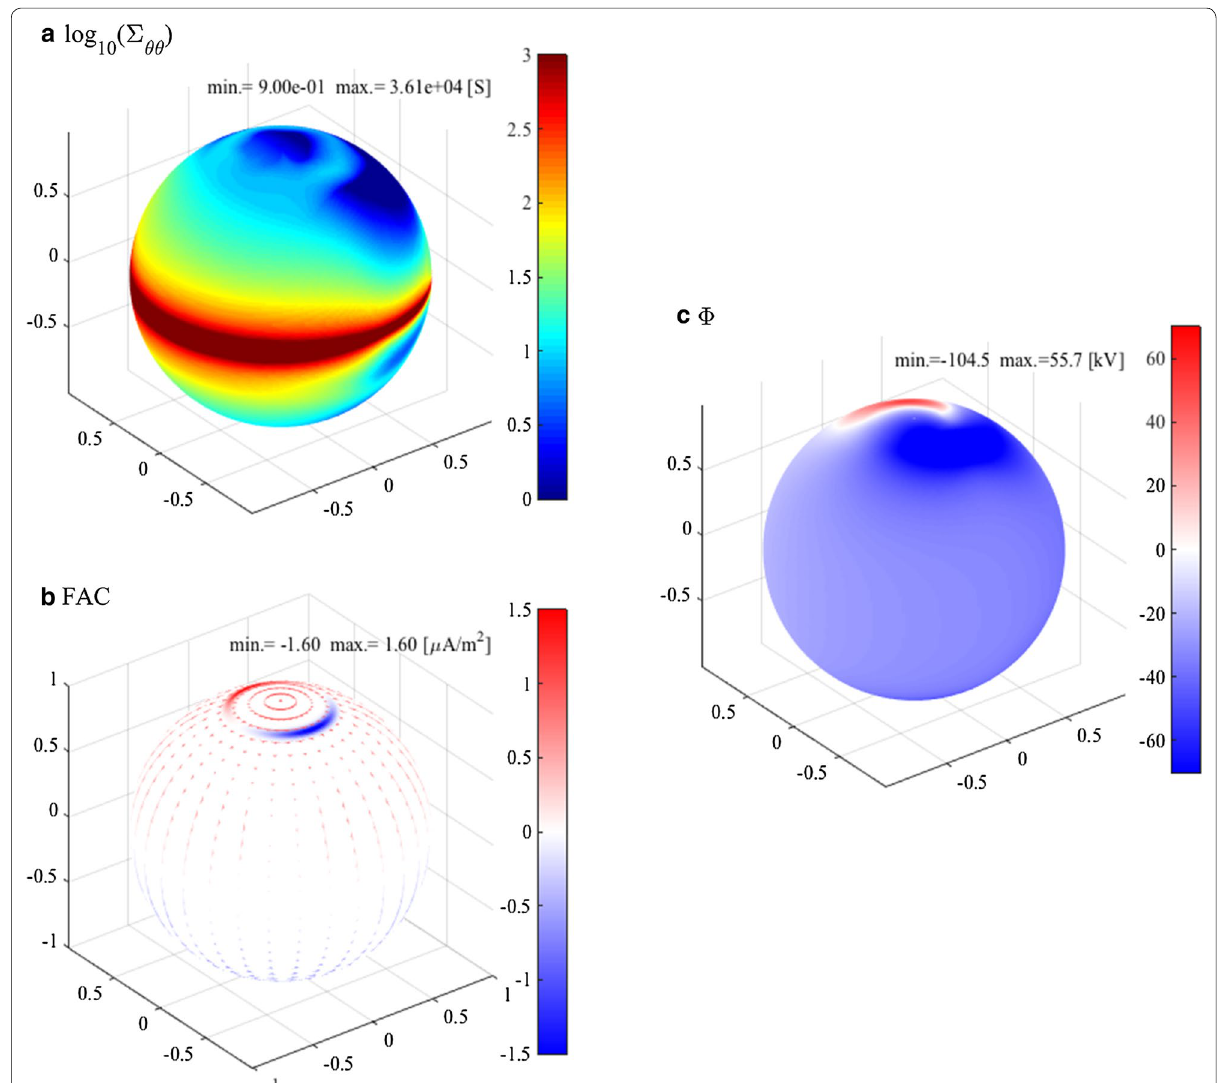
Fig. 11 A calculation example of GEMSIS‑POT. Each panel adopts the same format with noon being ahead to the left and north pole to the top. a Σ θθ shown in a logarithmic scale by color, b FACs distribution shown in a linear scale by color. The downward current is taken to be positive. c Calculated ionospheric